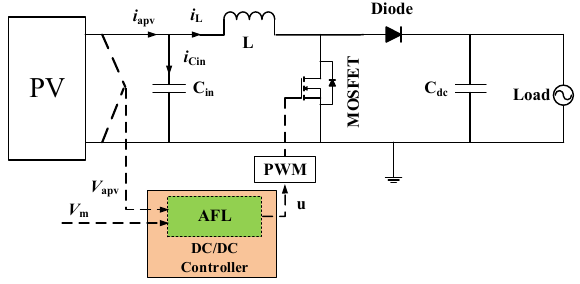
Figure 6. Topology of DC ‐ DC boost converter in PV system.